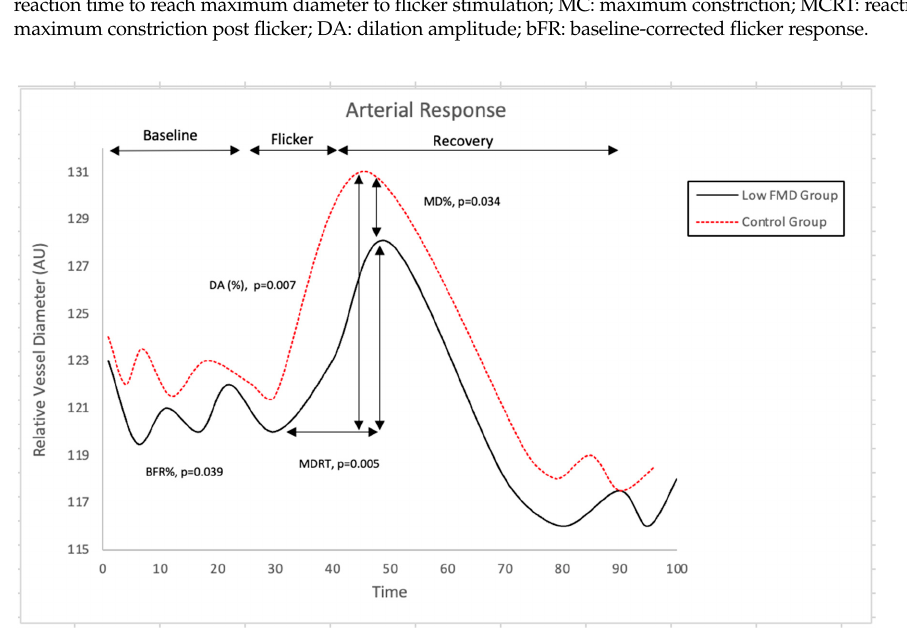
Figure 2. Comparison of Retinal Arterial Response Profile Across Groups. Abbreviations: AU, arbitrary units; BFR: baseline-corrected flicker response; DA: dilation amplitude; MD%: maximum dilation percentage; MDRT: reaction time to reach maximum diameter to flicker stimulation. There was, however, no correlation between the measured parameters at the macro- and microvascular level (all p > 0.05).